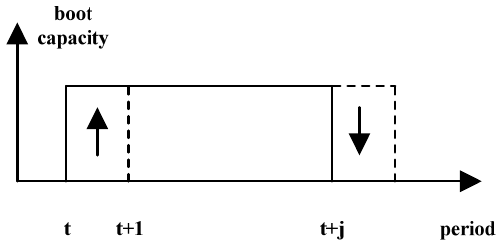
Figure 3. Sketch map of the system’s boot capacity equalization.